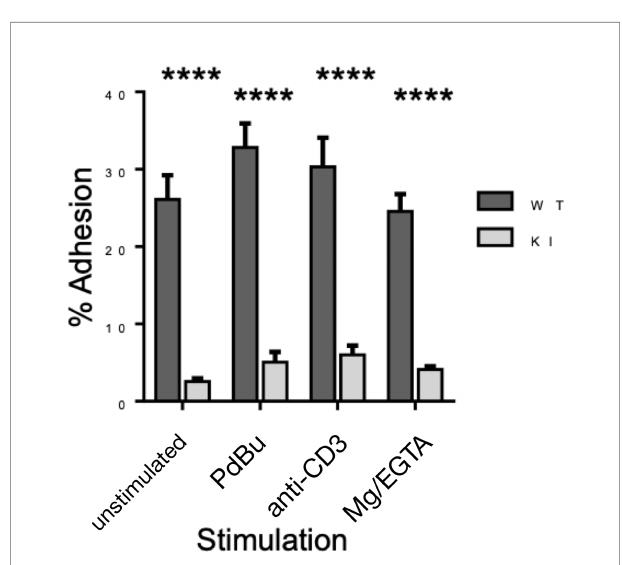
FIGURE 3 | Adhesion of WT and KI cells to coated ICAM-1, as measured by static adhesion assay. Pooled data from 3 independent experiments, each with 2 technical replicates. ****p <